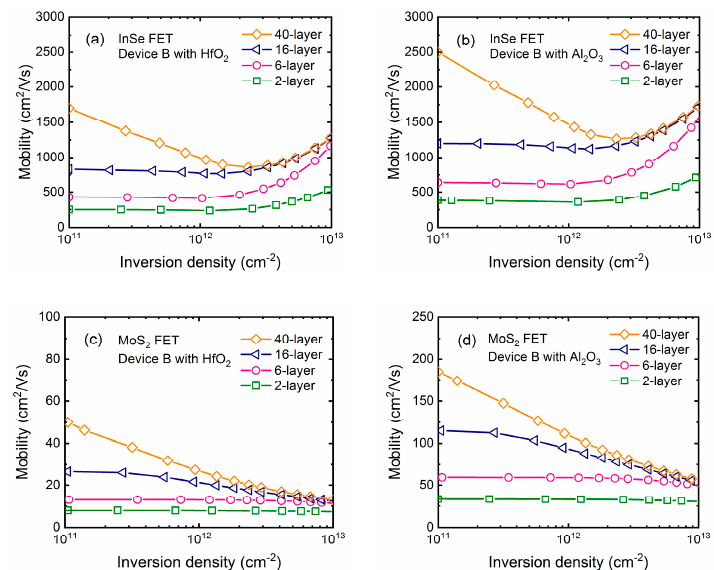
Figure 4. Mobility as a function of inversion density with layer number of 2, 6, 16, and 40 employing the dual ‐ gate structure as shown in Figure 1b in InSe and MoS 2 FET for comparison. EOT = 1 nm of high ‐ κ dielectric is assumed. ( a ) InSe FET with HfO 2 dielectric. ( b ) InSe FET with Al 2 O 3 dielectric. ( c ) MoS 2 FET with HfO 2 dielectric. ( d ) MoS 2 FET with Al 2 O 3 .